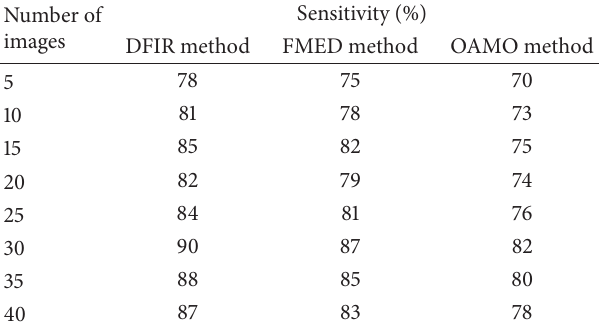
Table 1: Tabulation for